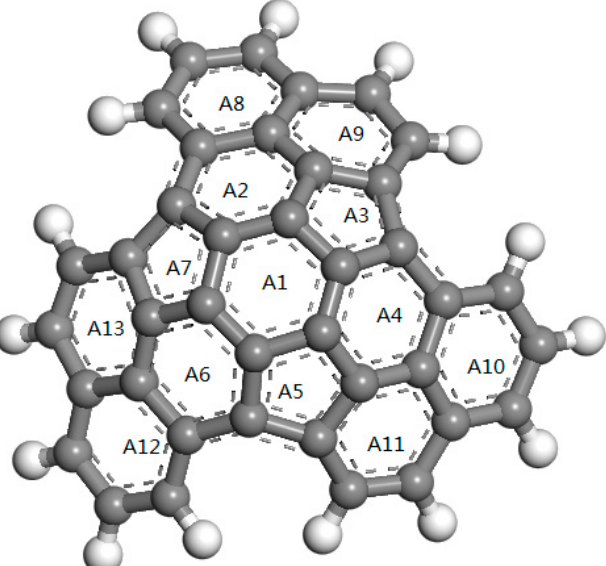
Figure 1. Molecular structure model with gray and white symbolizing carbon and hydrogen atoms respectively.